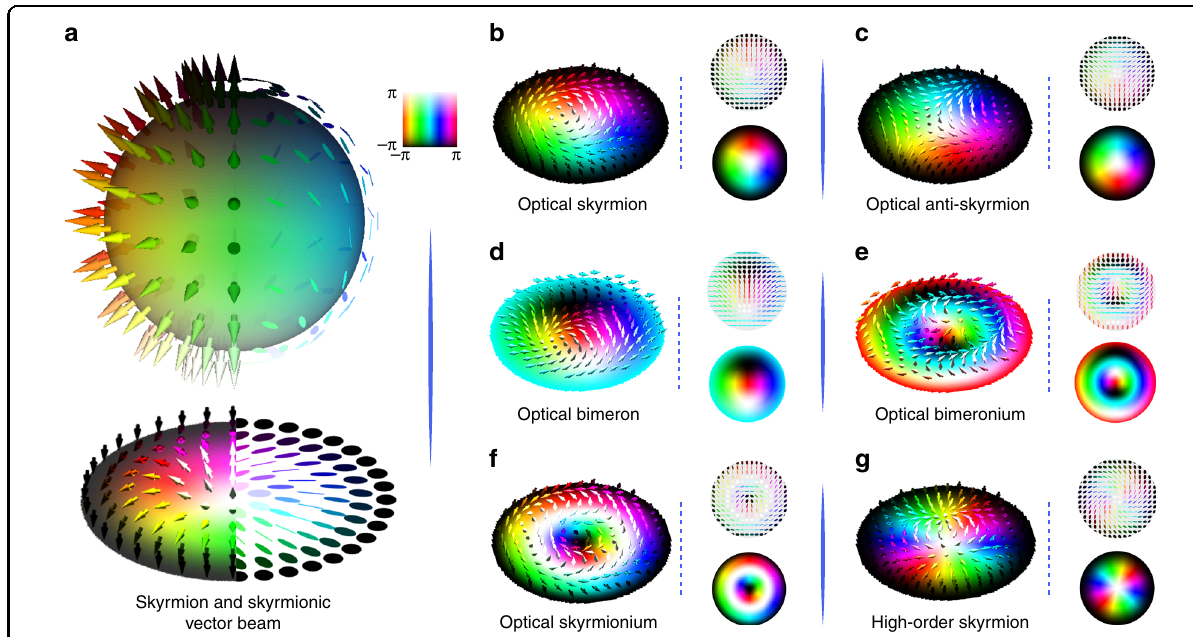
Fig. 6 Optical Skyrmions. a PS and Bloch sphere, Skyrmion and Skyrmionic vector beam. b – g are several representative optical skymionic fi elds (Skymion, anti-Skymion, Bimeron, Bimeronium, Skyrmionium, and high-order Skyrmion); the corresponding Stokes vector fi elds are also illustrated. The hue colour means the degree of azimuth of polarisation ellipse, and the darkness and brightness mean the ellipticity from left-hand circular polarisation to right-hand circular